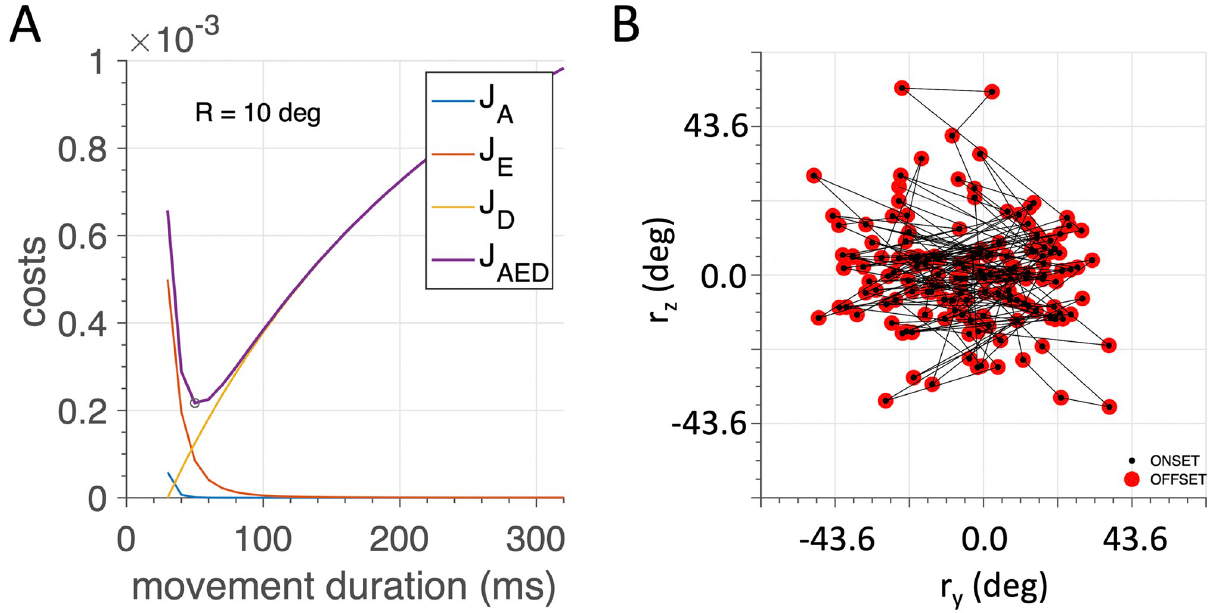
Fig 8. (A) Example of minimizing the total movement cost, J (purple curve), as function of the simulated saccade duration for a 10 deg rightward AED saccade. In this case, the optimum is reached at a duration of 50 ms (circular symbol). (B) Illustration of the first 150 goals for the saccade planner in degrees. The simulator started at the straight-ahead fixation point at (0,0), with the eye in the (assumed) primary position, at r 0 = 0, in a random direction, and any subsequent saccade started (black dot) from the end point of its predecessor (red symbol).